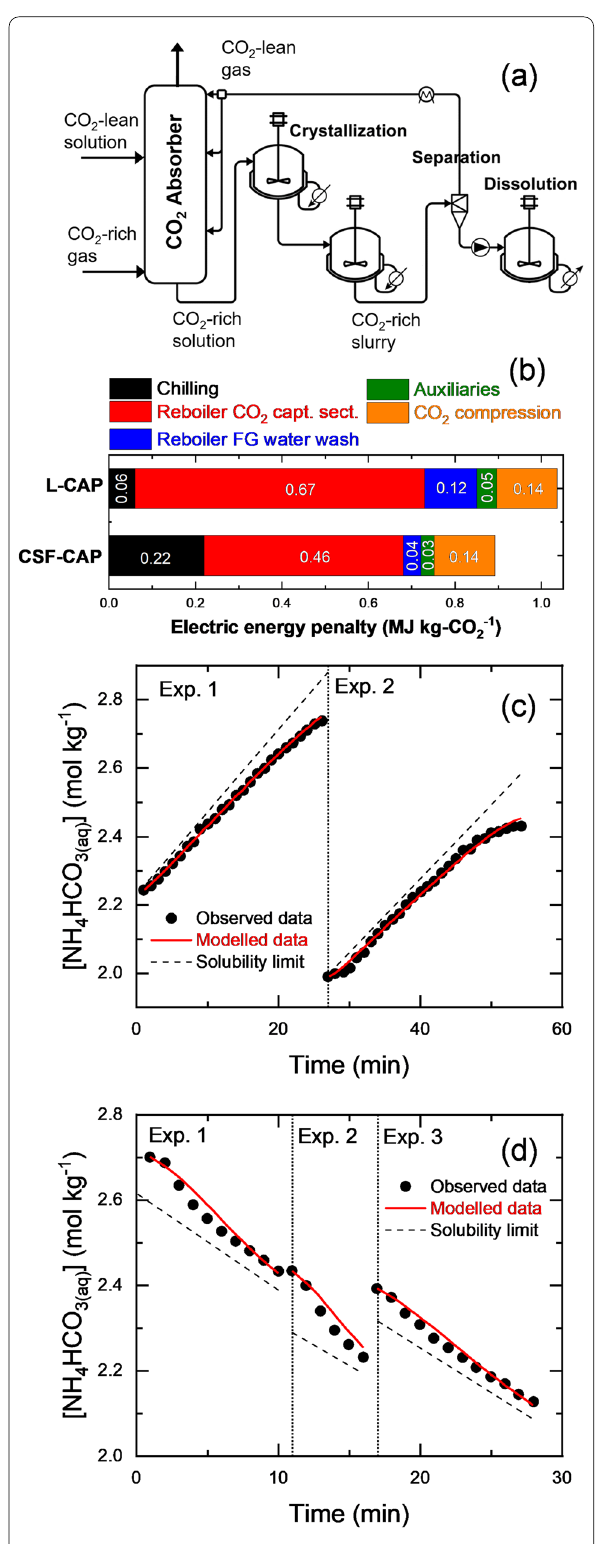
Fig. 4 a Flow diagram of the chilled‑ammonia process involving the precipitation process. b Estimated energy penalty of chilled‑ammonia process excluding precipitation (L‑CAP) and involving precipitation (CSF‑CAP) (Reproduced from [36] with permission from The Royal Society of Chemistry). c Crystal growth rate and d dissolution rate of ammonium bicarbonate at different concentration of ammonia (Reproduced with permission from [37]. Copyright 2019 American Chemical